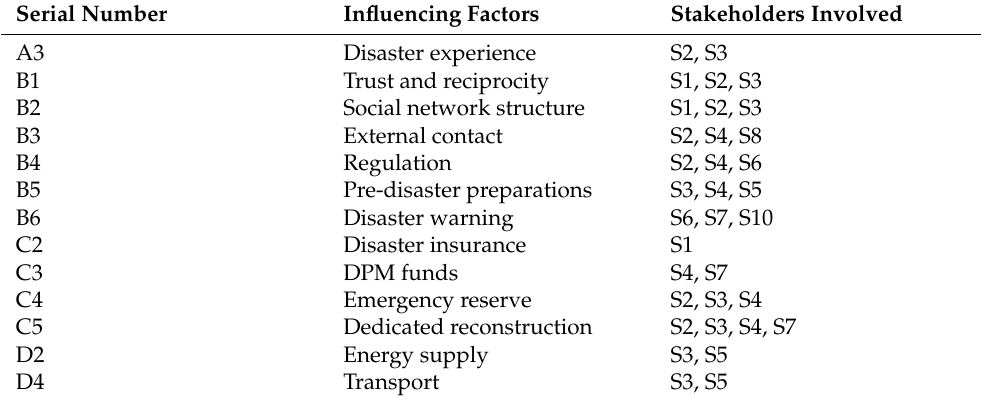
Table 5. The influencing factors of waterlogging resilience and the related stakeholders.